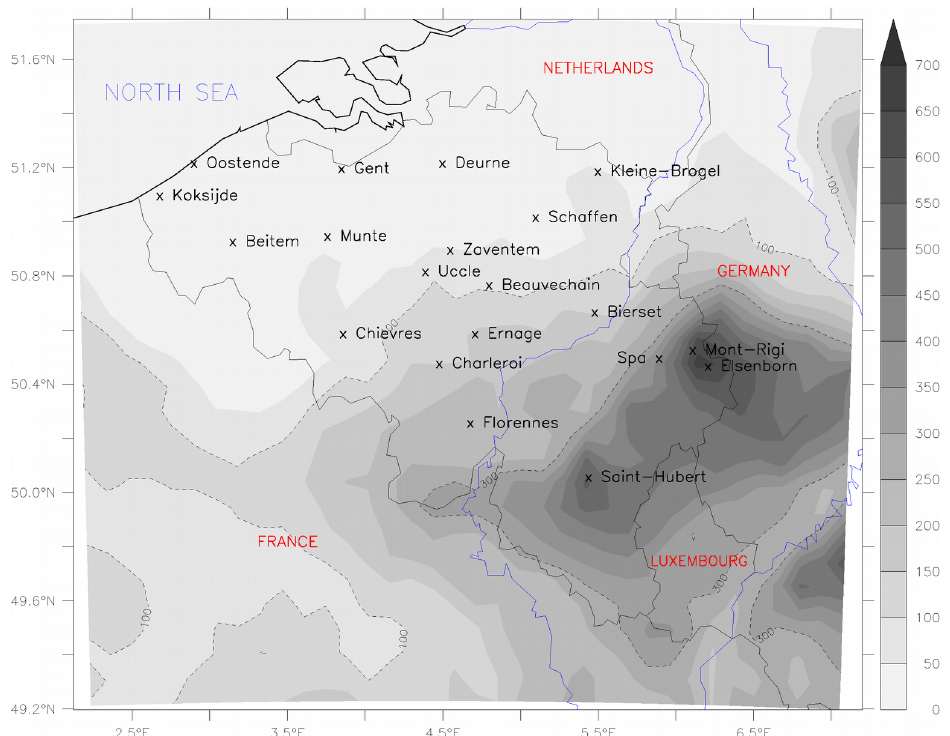
Figure 1. Model elevation of the study area (in meters) and location of the weather stations of the surface synoptic observations network (SYNOP) used in this study (black crosses). Dotted black lines represent the 100 m and 300 m elevation and the blue lines represent the major rivers of our studied area.